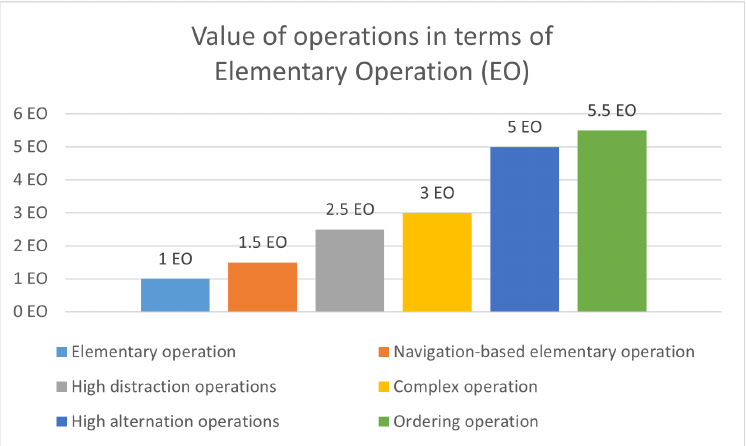
Figure 1. Comparison of the value of operations in terms of elementary